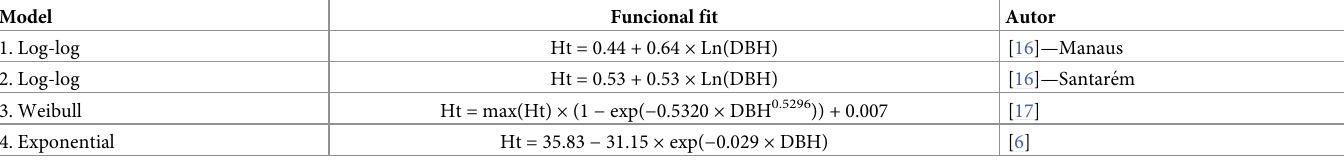
Table 2. Regional, continental and pan-tropical allometric equations tested to estimate total height. Model